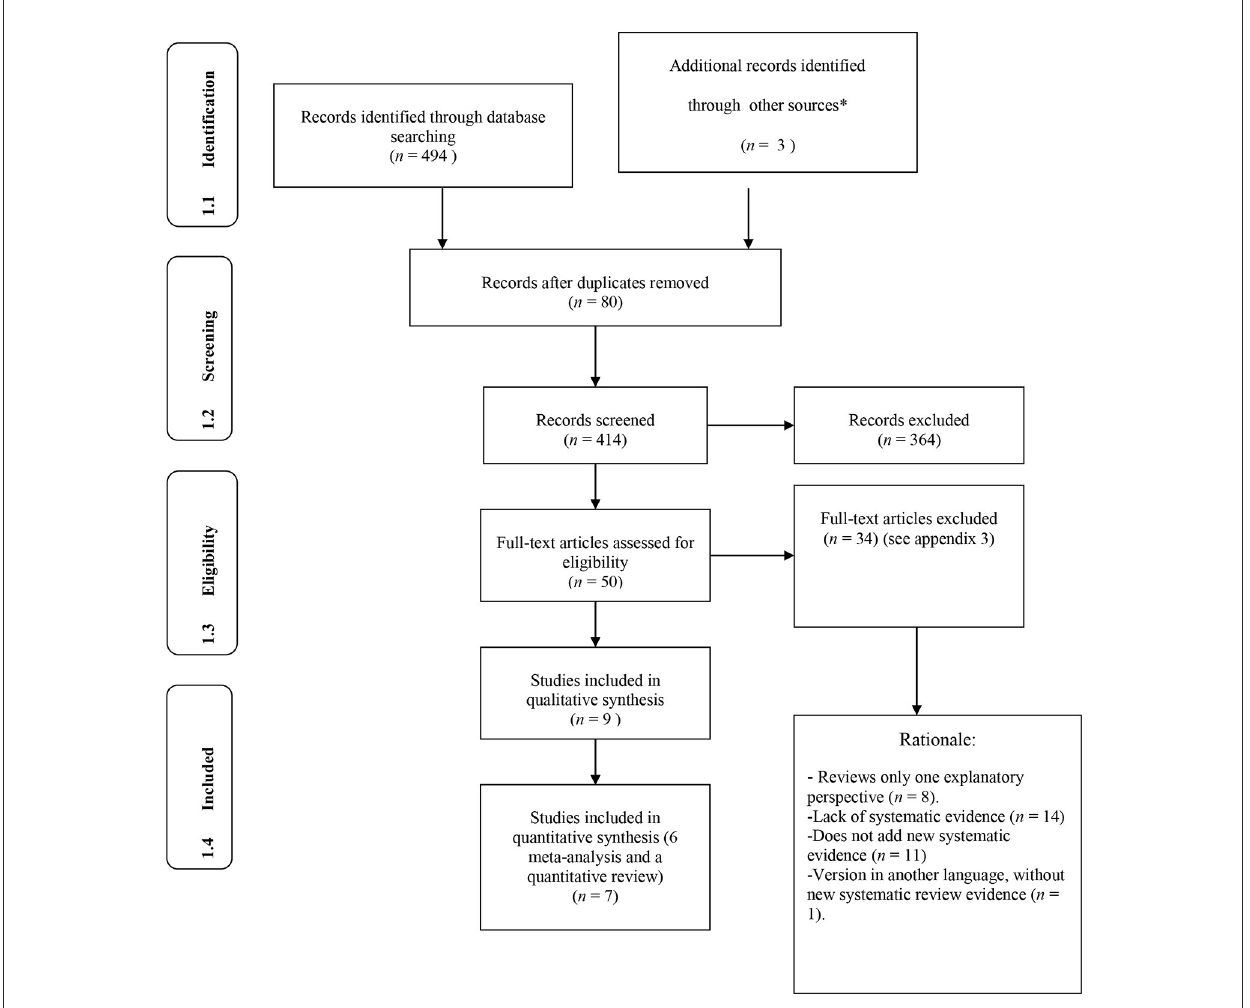
FIGURE1 Systematic review PRISMA. *Blogs and personal